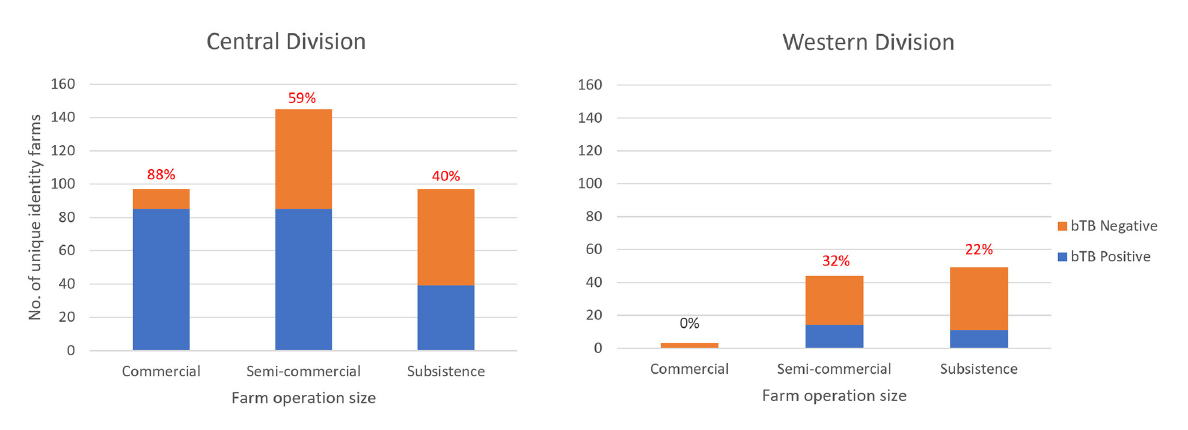
FIGURE5 The number of bTB negative and positive unique identity farms classified by operation size, based on tests conducted by the Fiji BTEC program between 2015 and 2020. The % of farms with bTB reactors are shown above each